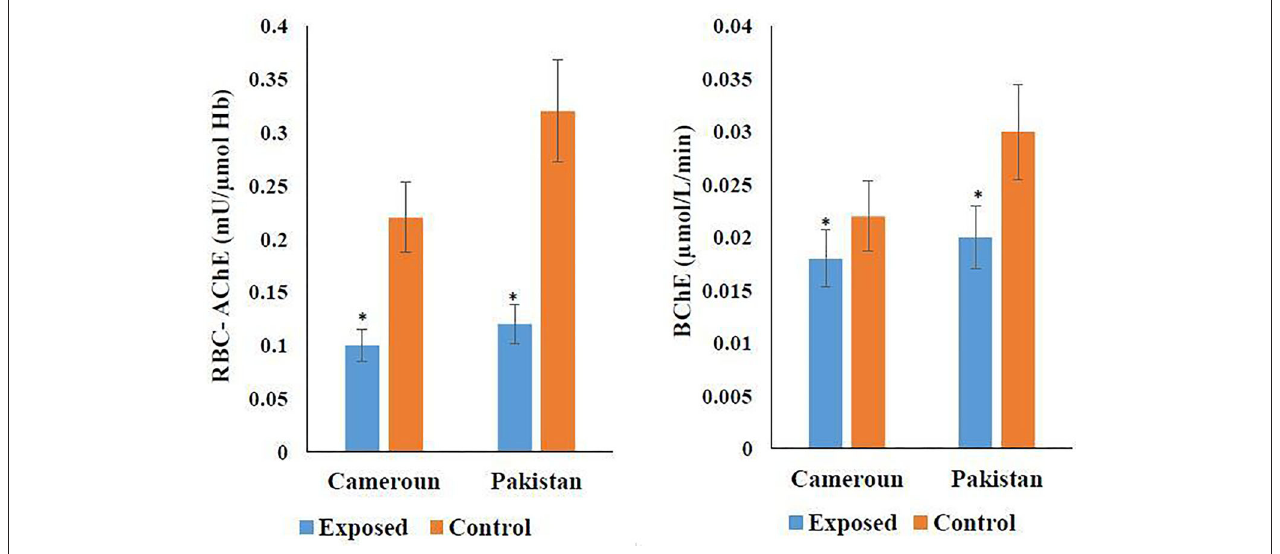
FIGURE 4 | Variation of cholinergic enzymes in Cameroonian and Pakistani groups. *Statistical differnce between exposed and unexposed groups ( P -value ≤ 0.05).